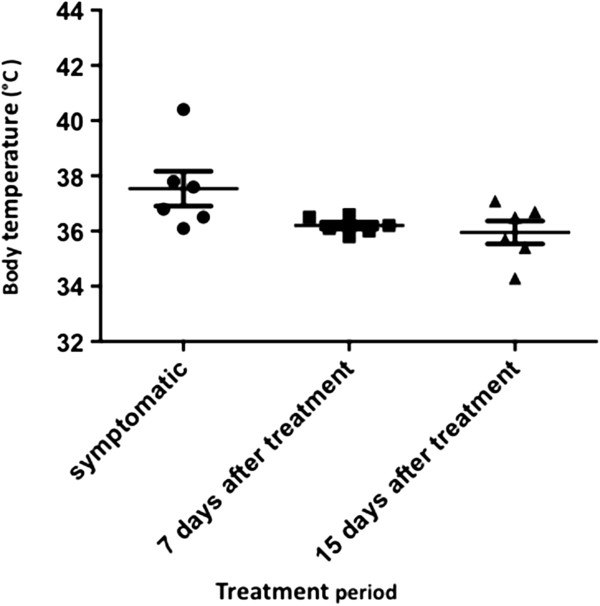
Body temperature of vivax malaria patients during different periods throughout the treatment. One Way RM Anova. N = 6.